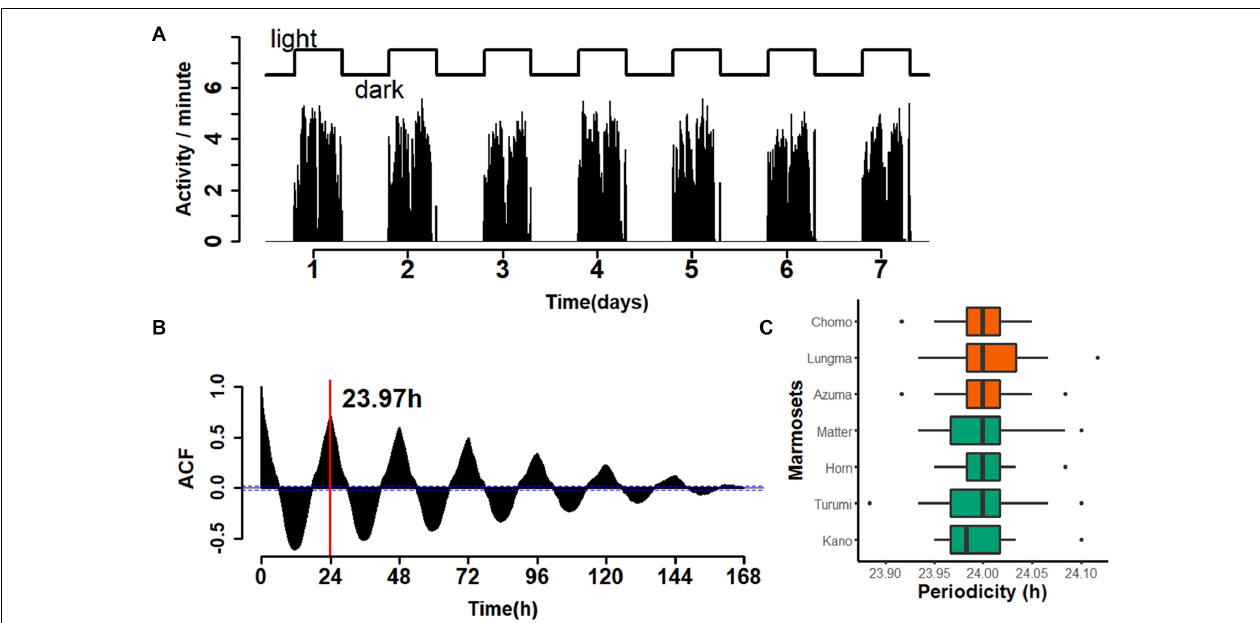
FIGURE 3 | Periodicity of 24 h for marmoset activity. (A) An example of a week-long, continuous recording for a single animal (Kano, recorded in week 23). Top, light–dark cycle of the breeding room. Bottom, aggregated number of movements for each minute. Movements were highly restricted during the light period. (B) Auto-correlogram of marmoset activity in the same week of the same animal as in panel (A) . Red line, estimated duration of a single cycle (23.97 h for the week). (C) Median ± inter-quartile range of the cycle duration for each marmoset is shown with the ordinal box plot. The color codes are the same as those used in Figure 2